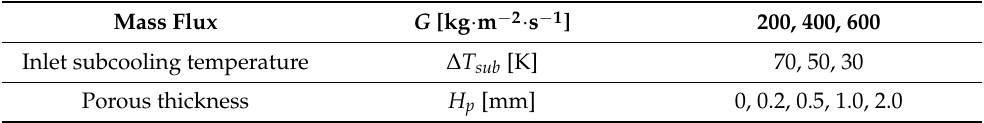
Table 1. Experimental parameters and conditions.